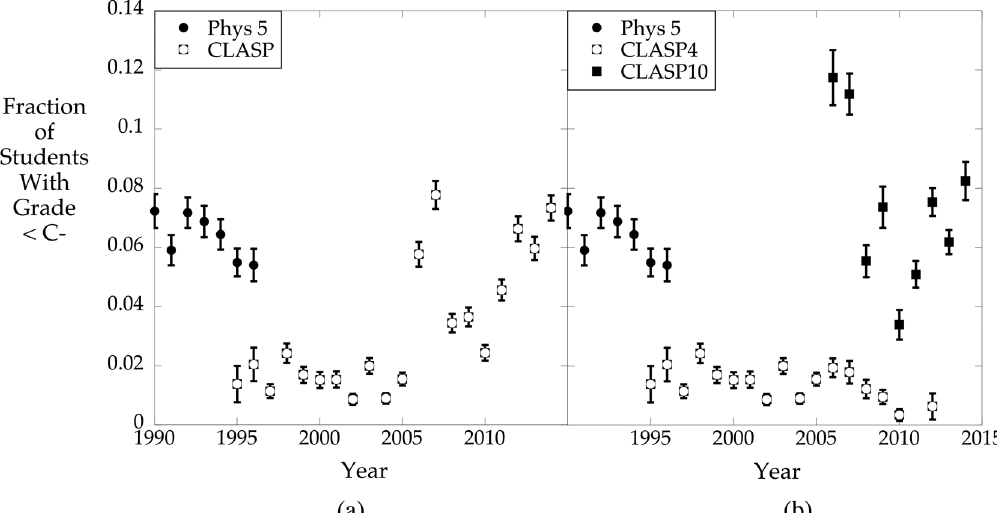
FIG. 1. Fraction of students that were unsuccessful in physics by year. The number of students per year in these classes varied from an average of about 2300 in the early 1990s to about 3600 in the middle 2010s. (a) Fraction of students receiving a course grade less than C − as a function of year they took the course. Phys 5 is the traditional course that was replaced by the CLASP series between 1995 and 1997. Only the first two courses in the three-quarter series are included for any year because there are many majors requiring only these first two quarters so the student population changes somewhat in the third quarter. The error bars are (cid:2) standard error. An increase in the fraction of students with these low grades after 2006 is clear. (b) With CLASP4 and CLASP10 grade scales plotted separately, the increase in the fraction of students with these low grades after 2006 can be seen to be due to the use of the 10-point grade scale in many